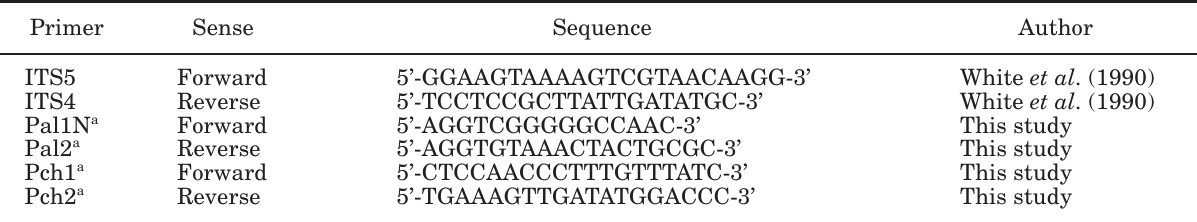
Table 2. Details of primers used in this study. Primer